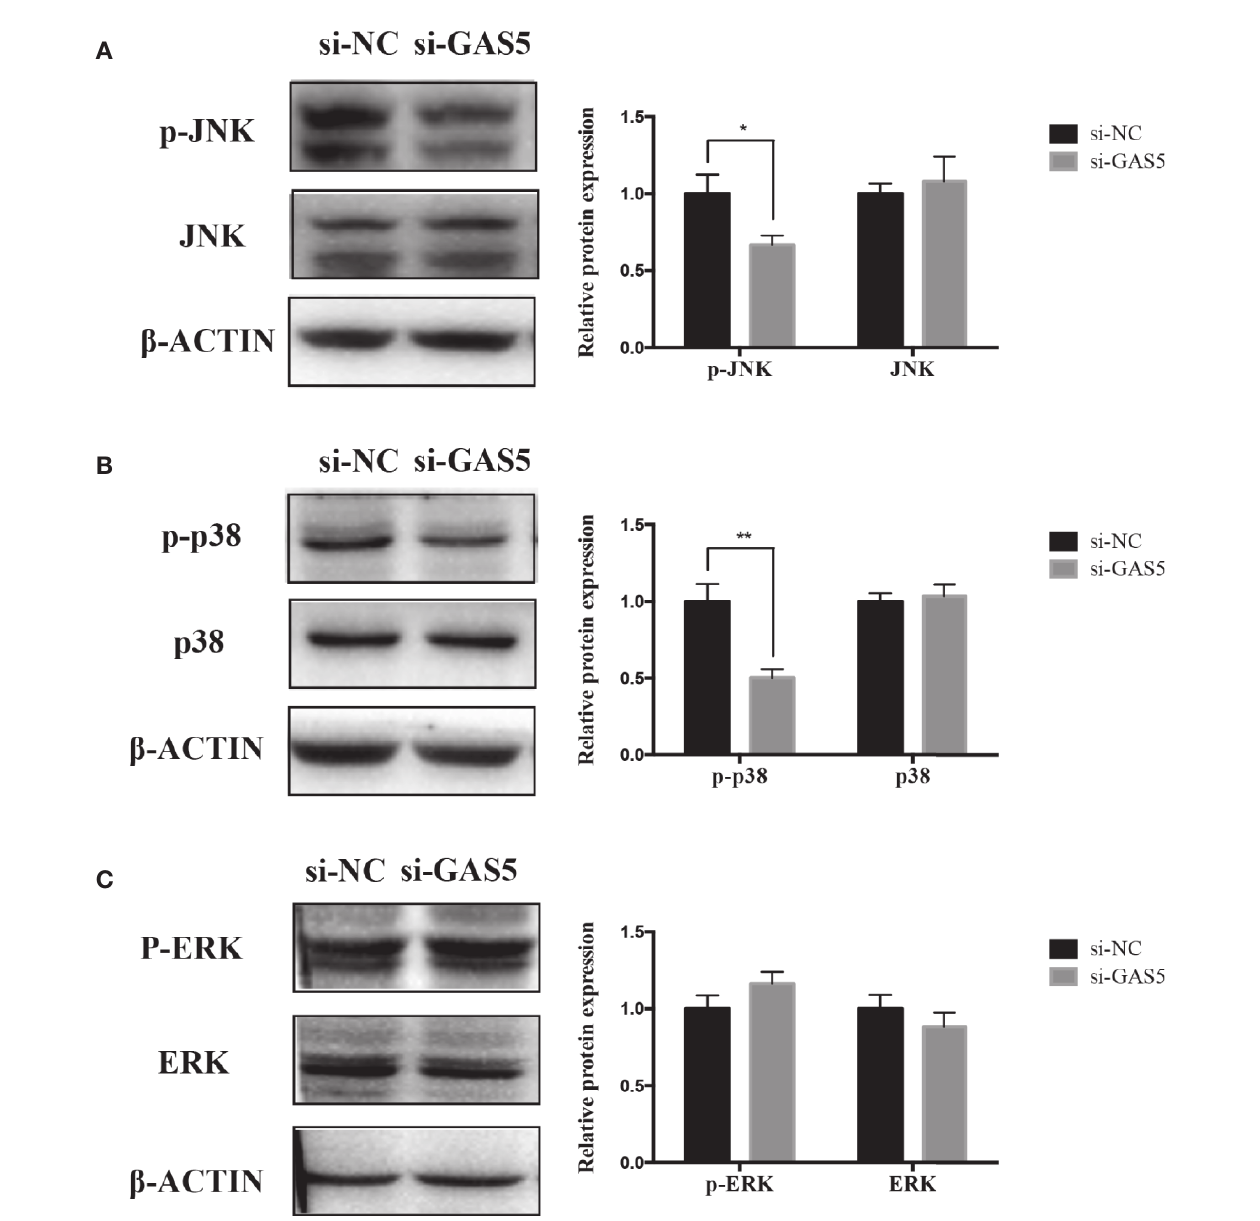
FIGURE 6 | Knockdown of GAS5 weakened the phosphorylation of JNK and p38 in hPDLSCs. (A) : Western blot analysis of phosphorylated JNK (p-JNK), JNK and b -ACTIN in hPDLSCs transfected with si-NC or si-GAS5. Histogram showed the quanti fi cation of the band intensities. (B) : Western blot analysis of phosphorylated p38 (p-p38), p38 mitogen-activated protein kinase (p38), and b -ACTIN in hPDLSCs transfected with si-NC or si-GAS5. Histogram showed the quanti fi cation of the band intensities. (C) : Western blot analysis of phosphorylated ERK (p-ERK), ERK and b -ACTIN in hPDLSCs transfected with si-NC or si-GAS5. Histogram showed the quanti fi cation of the band intensities. *p < 0.05, **p < 0.01. hPDLSCs, human periodontal ligament stem cells; GAS5, lncRNA growth arrest speci fi c transcript 5; si-NC: small interfering RNA negative control; si-GAS5: the small interfering RNAs that target GAS5; NC, negative control; JNK, c-Jun N-terminal kinase; ERK, intracellular signal-regulated kinase